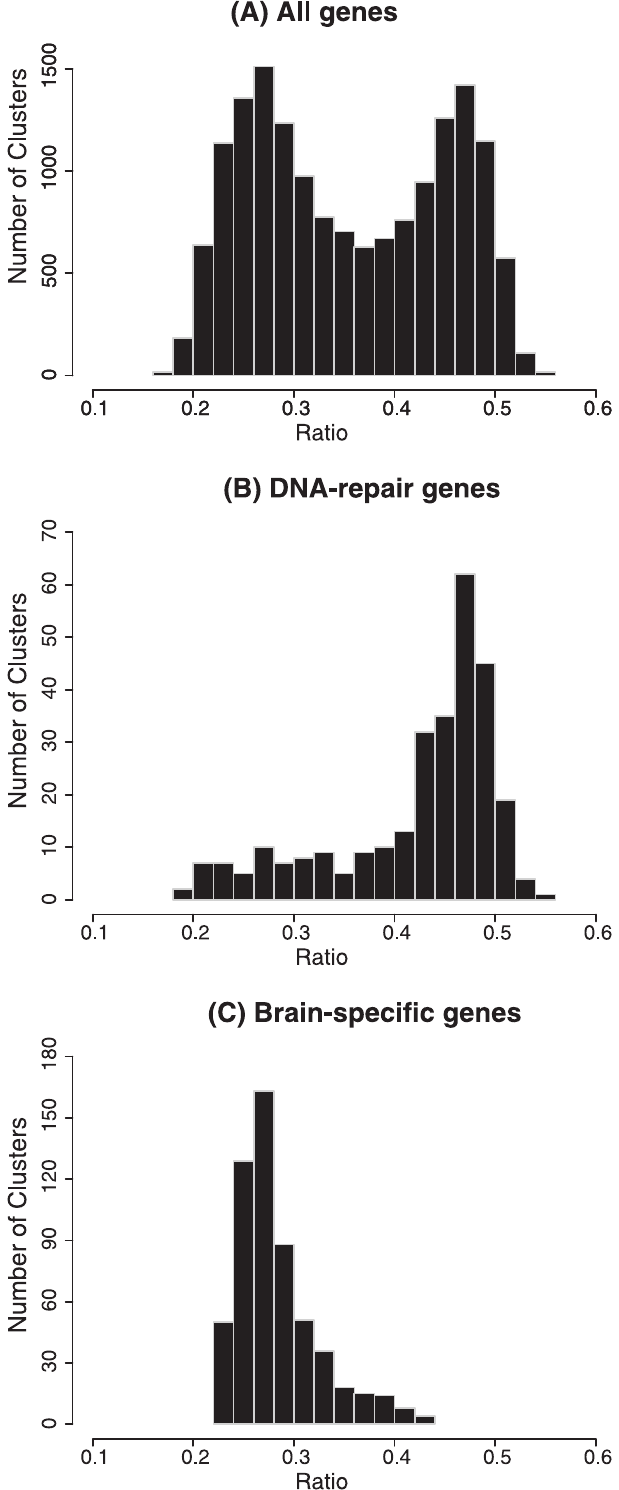
Figure 3. Frequency of Bidirectional Promoters Each of 16,078 genes represented in the microarray data was grouped with its 500 most-related genes into an expression cohort. The ratio of bidirectional promoters in each expression cohort was plotted for three categories: (A) all genes, (B) DNA-repair genes, or (C) brain-specific